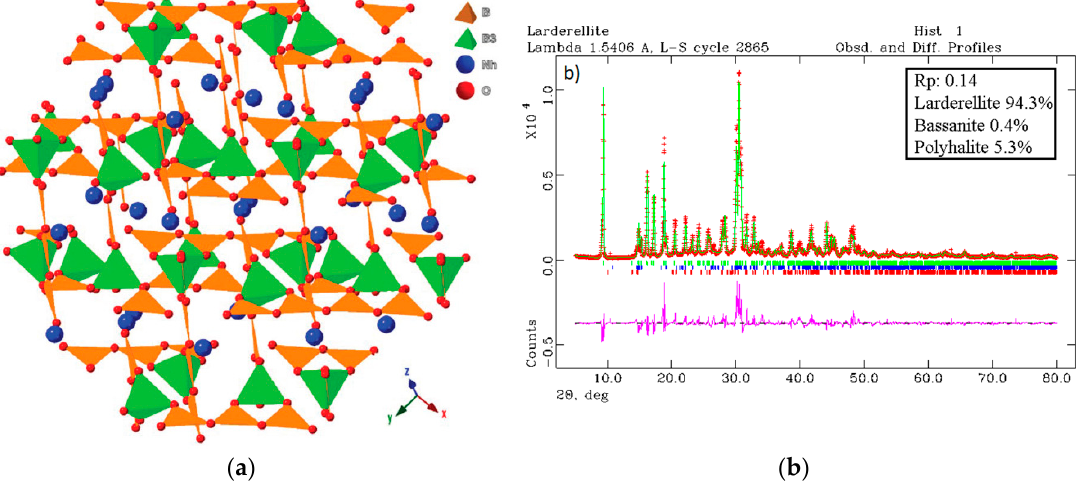
Figure 1. ( a ) Crystal structure of larderellite. In orange, the B trigonal polyhedra, and in green, the B tetrahedra. The blue balls indicate the NH 4 groups. ( b ) The X-ray diffraction spectrum of the sample indicated as larderellite refined with the Rietveld method [50], using GSAS EXPGUI [51,52] software.